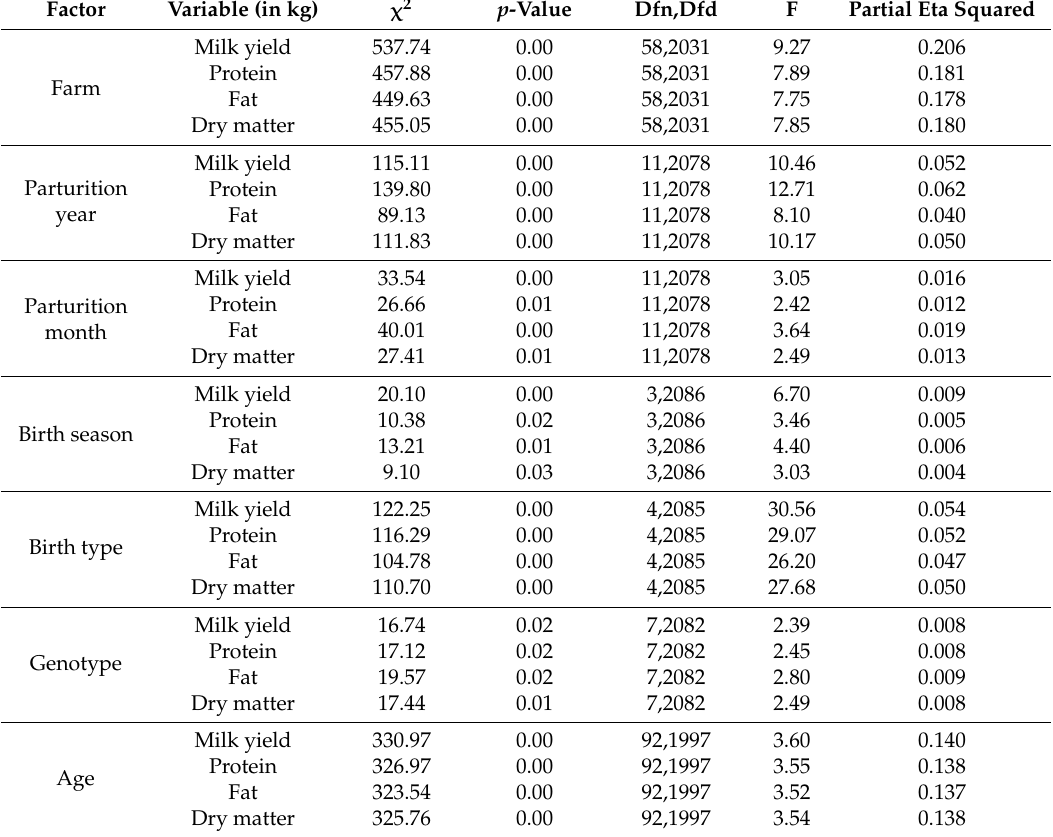
Table 1. Kruskal-Wallis H test and partial eta squared ( η p 2 ) coe ffi cient results (for milk yield (kg), protein (kg), fat (kg), and dry matter (kg) for Murciano-Granadina goats as described in Pizarro et al.